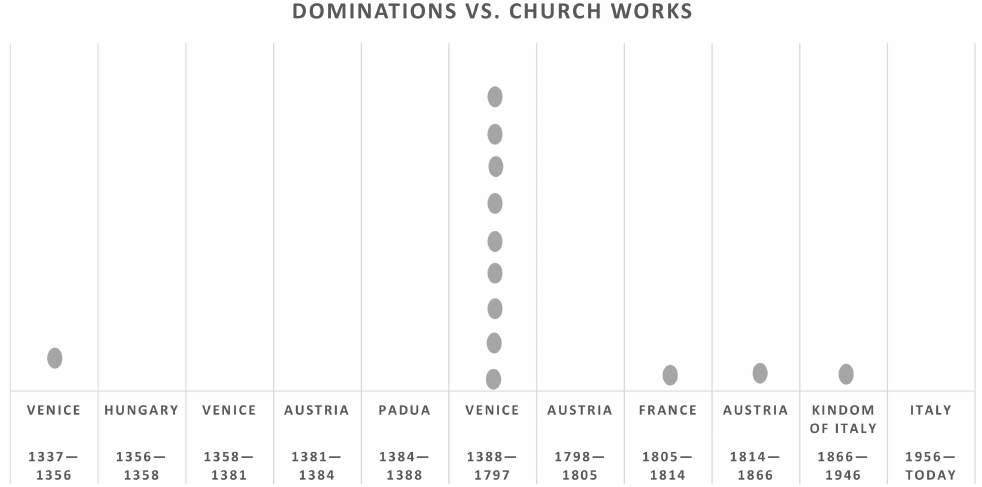
Figure 10. The Dominations’ periods vs. the number of architectural